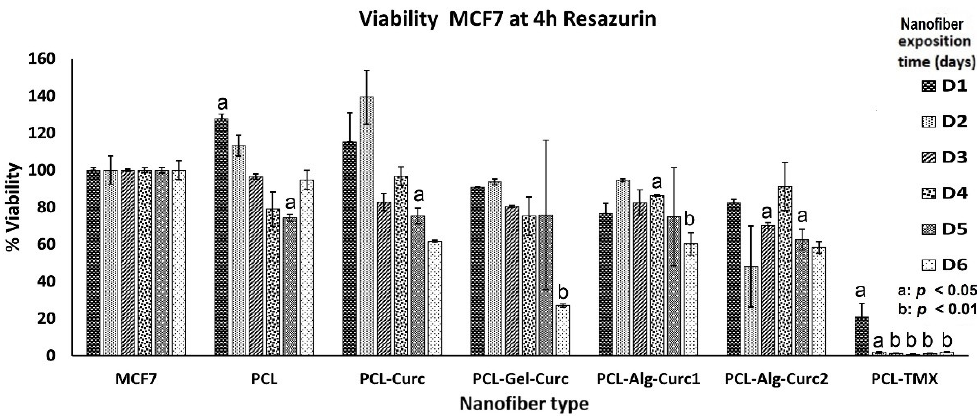
Figure 7. Viability percentage of MCF-7 cells treated with the different nanofibers for six days. The reduction in resazurin to resorufin was measured at 4 h. The student’s t -test was used to establish significance.